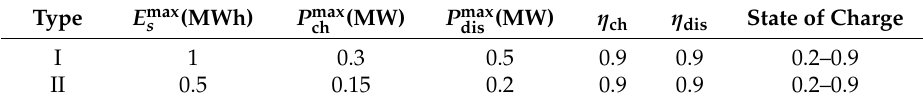
Table 2. Parameters of energy storage systems